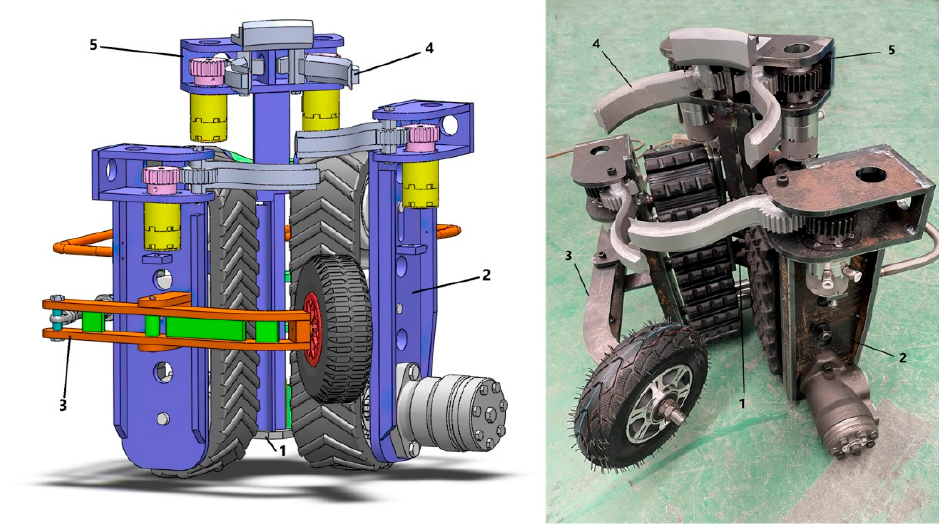
Figure 1. Monkeybot: 1—frame; 2—walking mechanism; 3—clamping mechanism; 4—cutting mechanism; 5—obstacle avoidance mechanism.